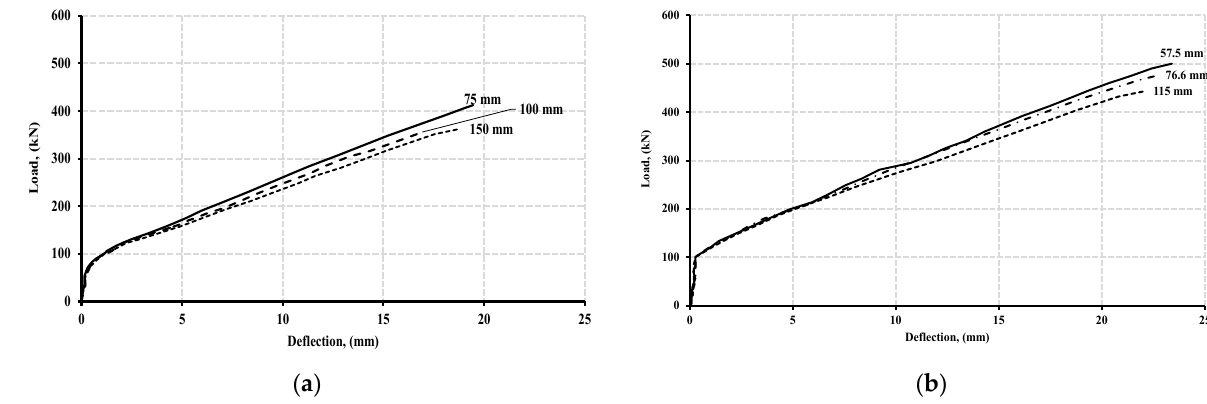
Figure 11. Load-deflection curve for varied stirrups spacing at mid-span for beam specimens with a concrete strength of ( a ) 40 MPa, and ( b ) 80 MPa.